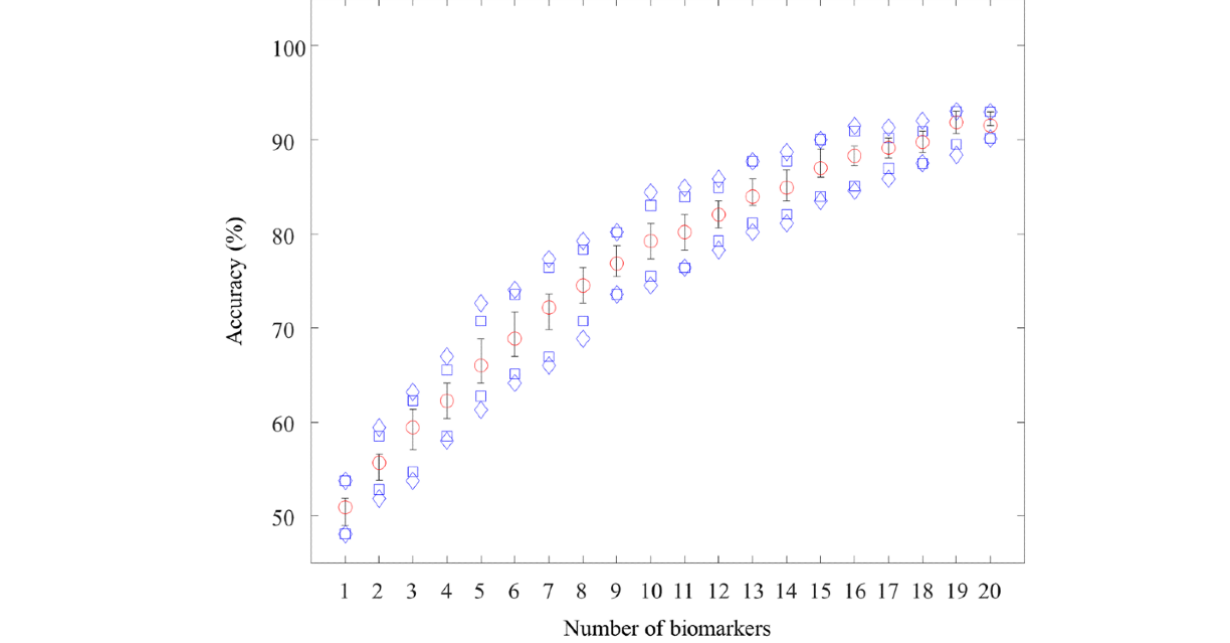
Figure 3. Estimated accuracy values according to the number of available biomarkers. Red circles represent the median. The bars at the top and bottom represent the 75th and 25th percentiles, respectively. The blue rectangles at the top and bottom represent the 90th and 10th percentiles, respectively. The blue diamonds at the top and bottom represent the 95th and 5th percentiles,